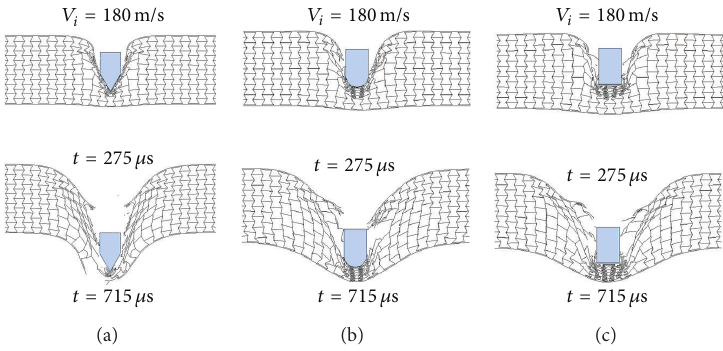
Figure 24: Impact processes of auxetic HSPs by (a) conical, (b) hemispherical, and (c) blunt nose projectiles at 𝑉 𝑖 = 180 m/s.